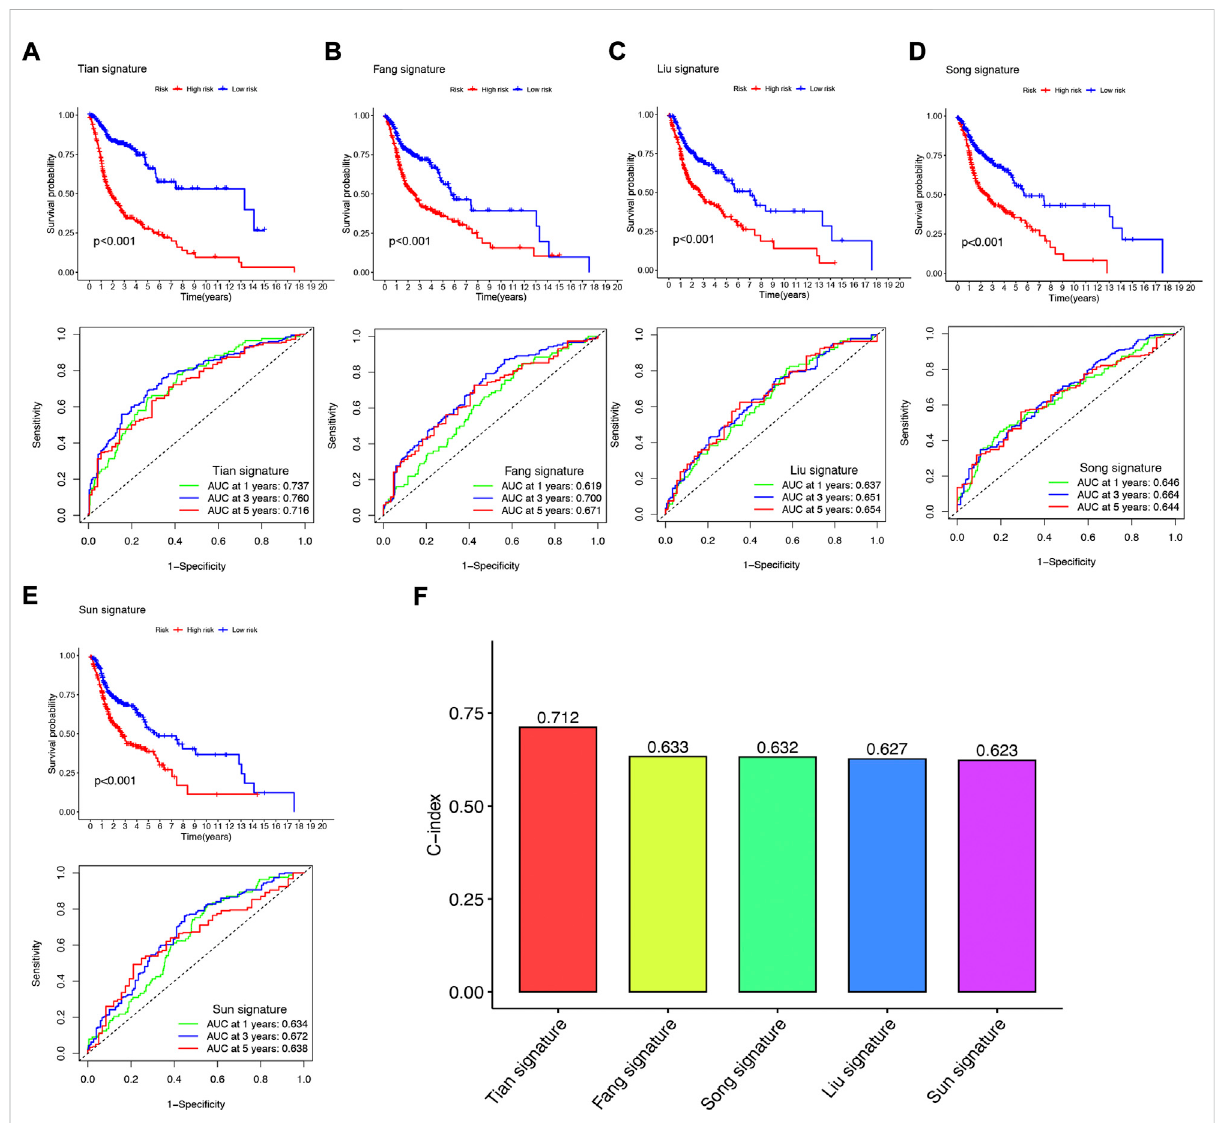
FIGURE 8 ComparisonoftheNFRGssignaturewithothermodels (A) KMcurvesandROCsforNFRGssignature. (B – E) KMcurvesandROCsforriskmodels constructed by others. (F) C-indexes for fi ve risk